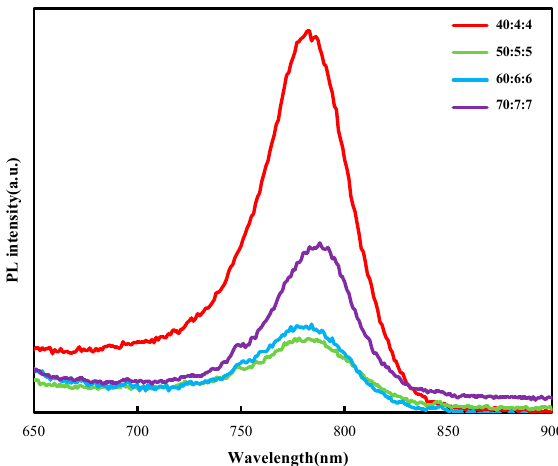
Figure 4. Photoluminescence spectroscopy of perovskite layers prepared with different concentrations of formamidine methylamine halide precursors solutions.